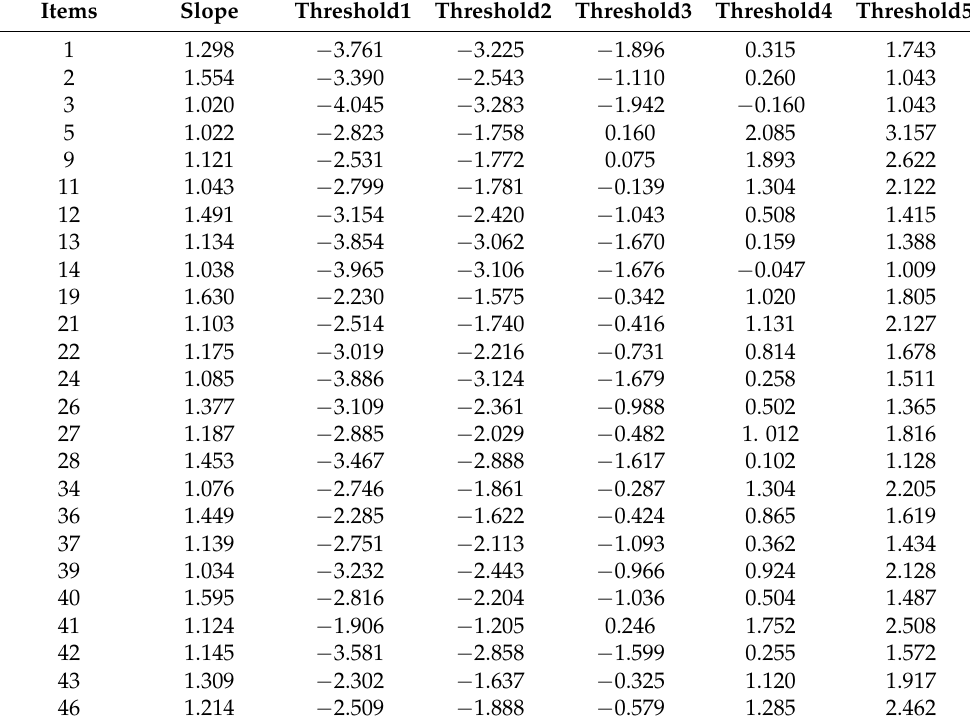
Table 1. Descriptive statistics of